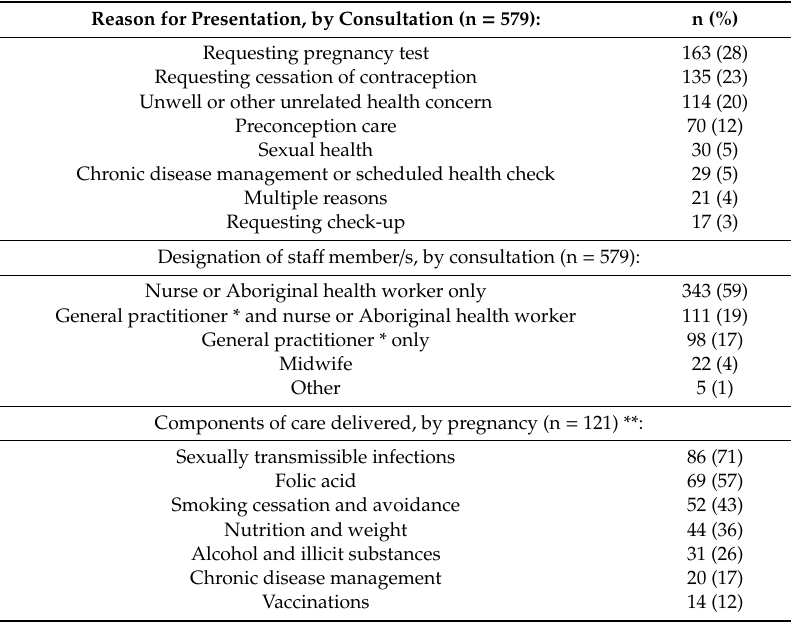
Table 2. Characteristics of preconception care